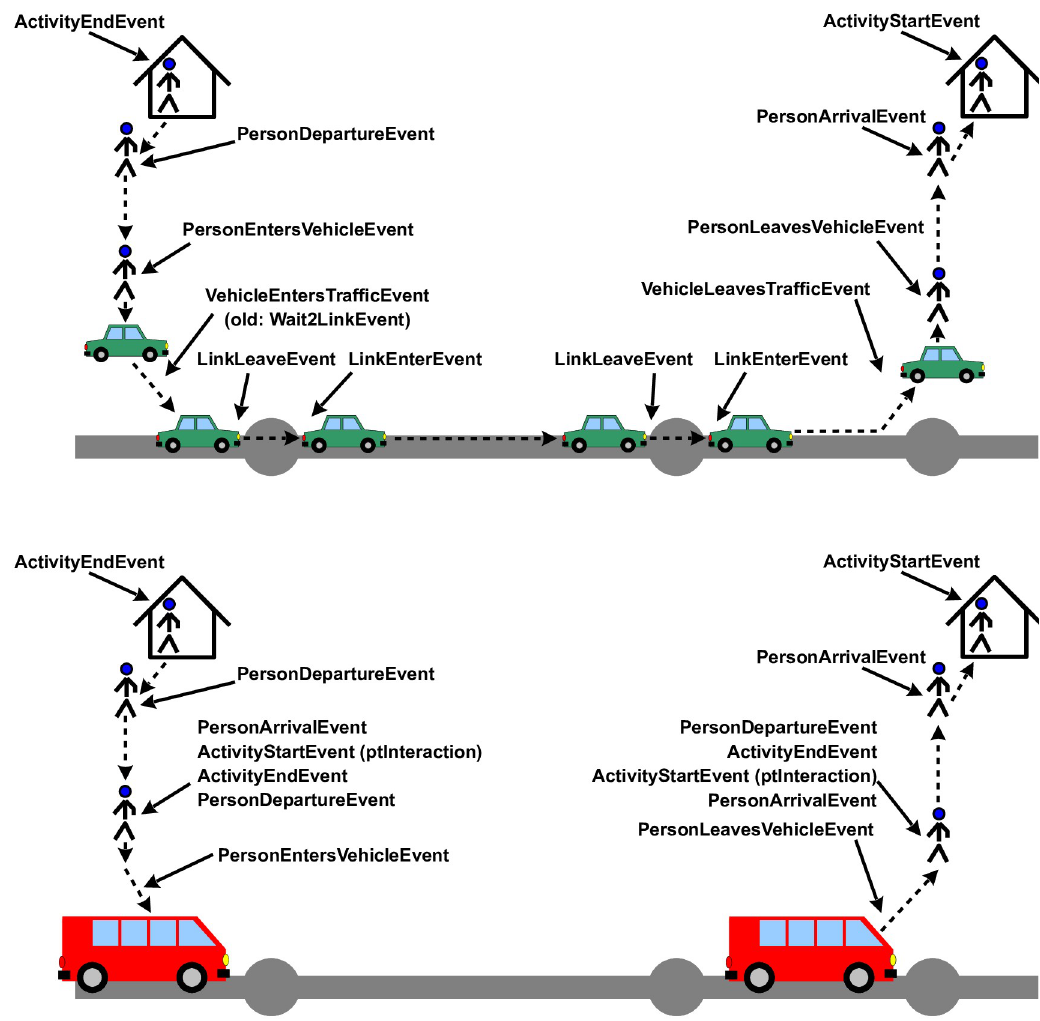
Fig 1. Events for travel. TOP: By individual vehicle. BOTTOM: By public transport. Source: